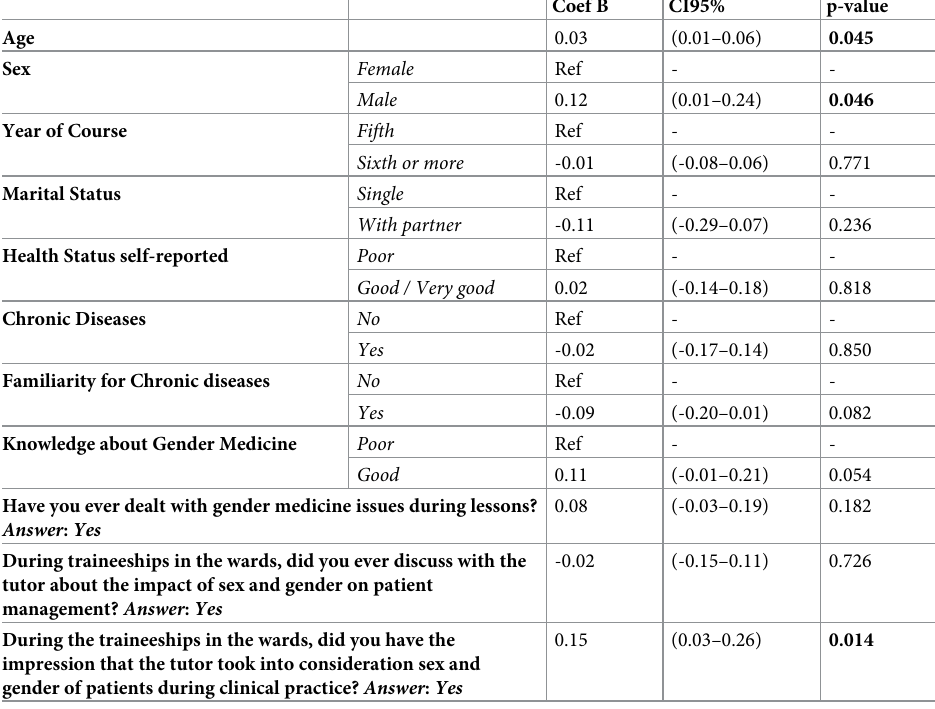
Table 5. Potential predictors of gender role ideology towards doctors